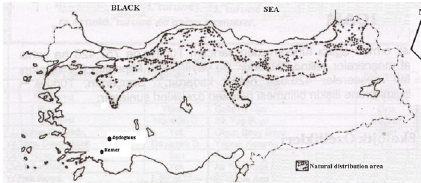
Figure 1: Natural distribution area of Scots pine in Turkey, and experimental sites.